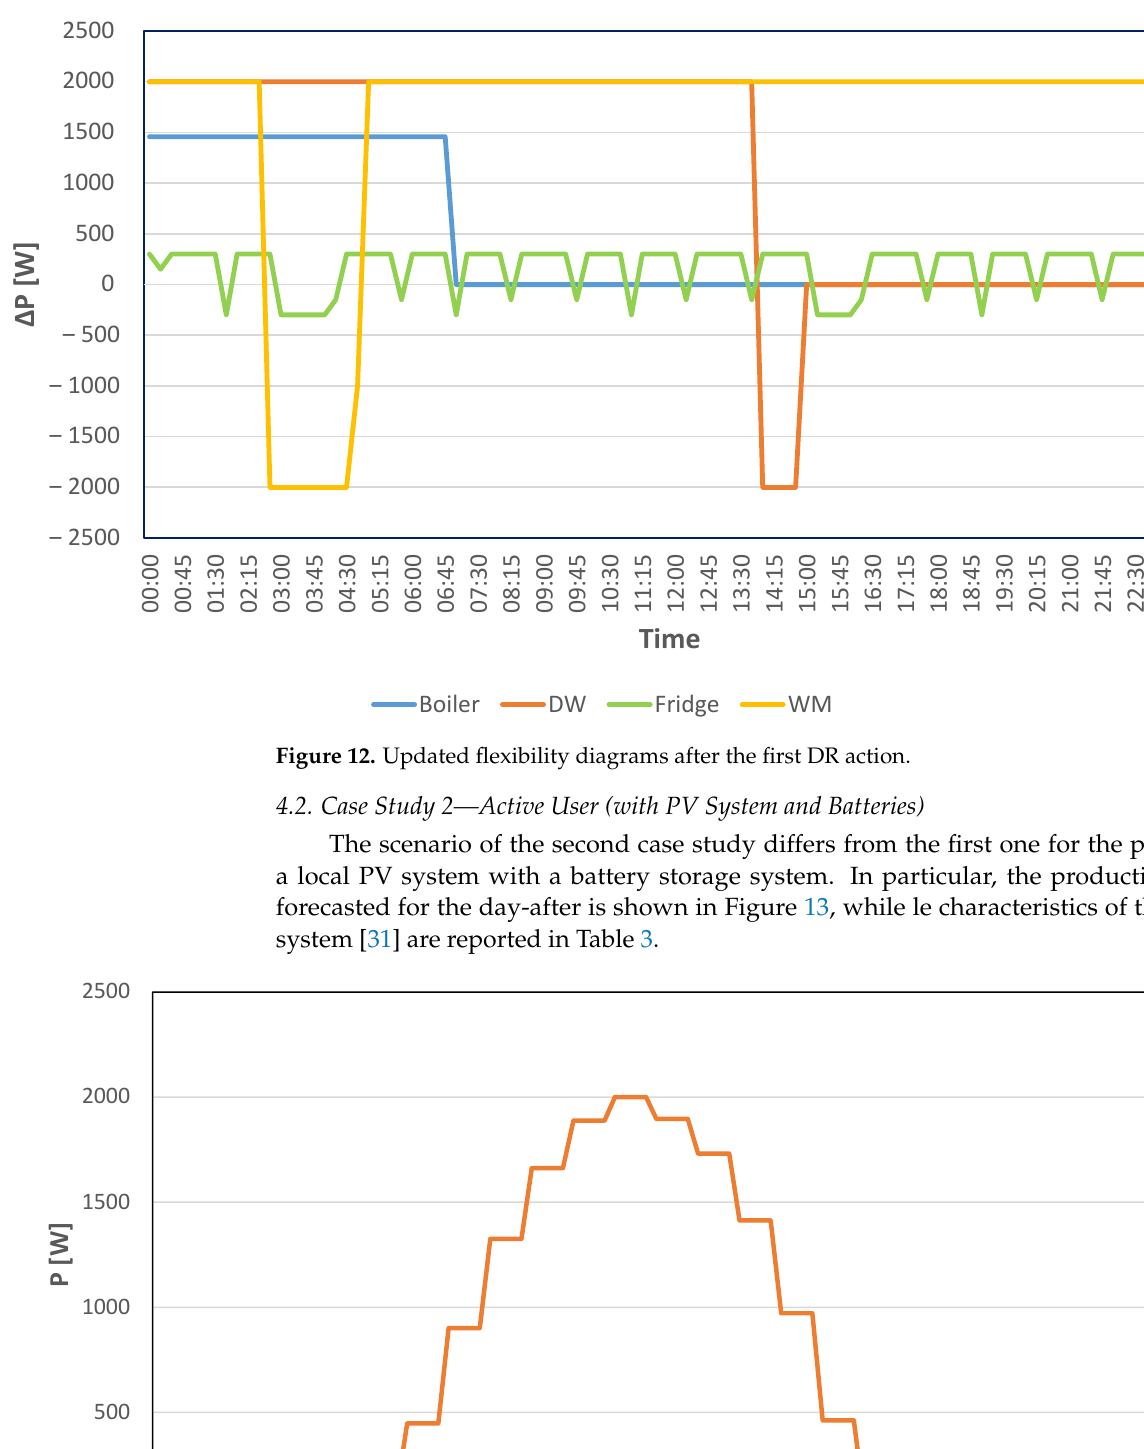
Figure 11. Comparison between updated and original load diagram after the second DR action.